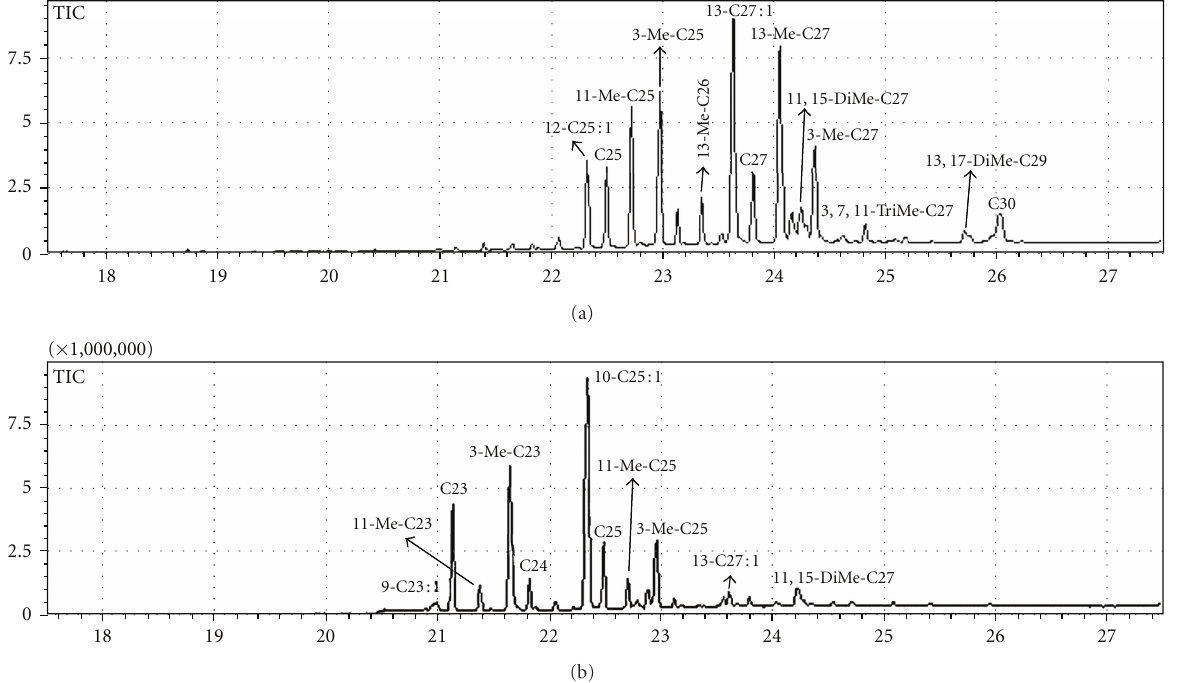
Figure 3: Total ion current chromatograms of hydrocarbons from head extracts of major workers of Solenopsis saevissima varieties A (top) and B (below) from Rio de Janeiro,